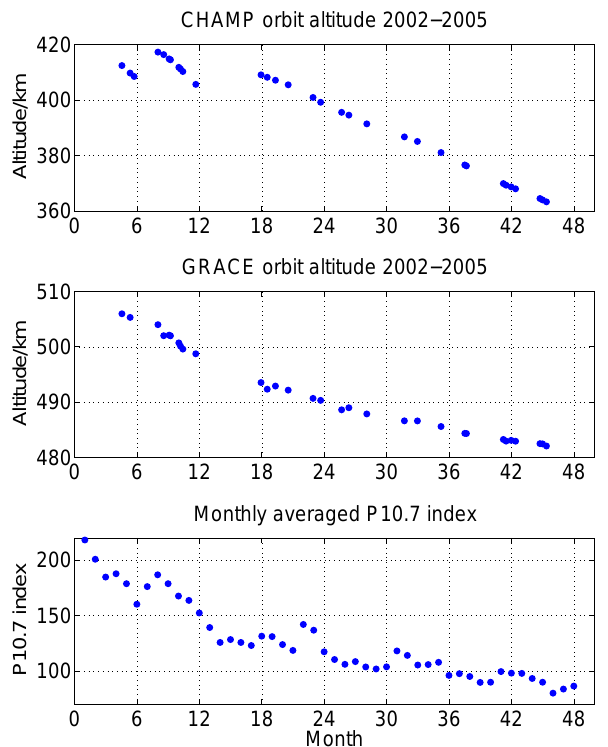
Fig. 1. The altitude (km) decays of CHAMP (top) and GRACE (middle) from April 2002 to September 2005. The x-axis represents the time starting from January 2002. Each dot represents the altitude averaged over one storm. In the bottom frame the evolution of the solar flux P10.7 is